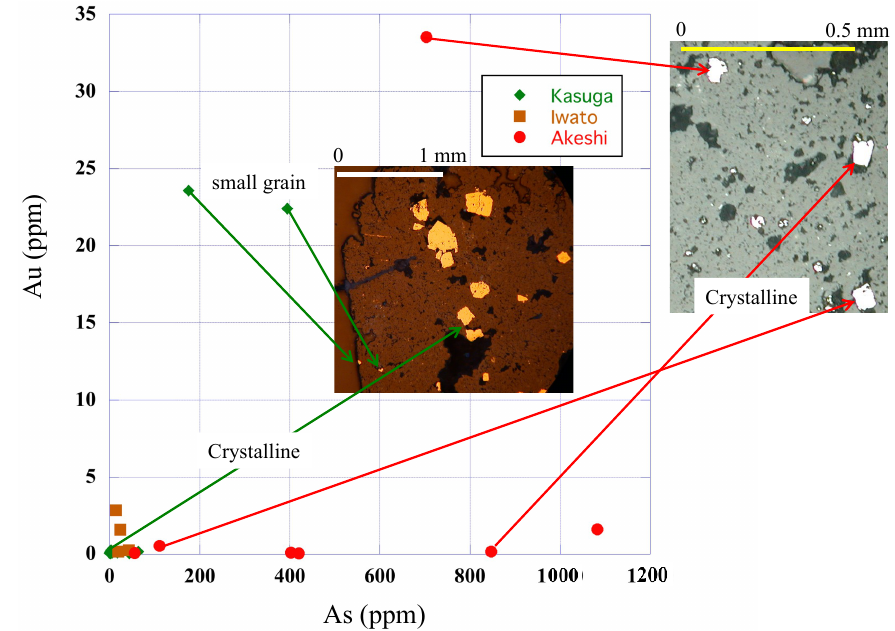
Figure 4. Au and As concentrations (ppm) in pyrite from the high-sulfidation Nansatsu-type (Kasuga, Iwato, and Akeshi) gold deposits. Reflected-light photos showing the shapes of pyrite grains are added to the graph. See Section 5.1 for